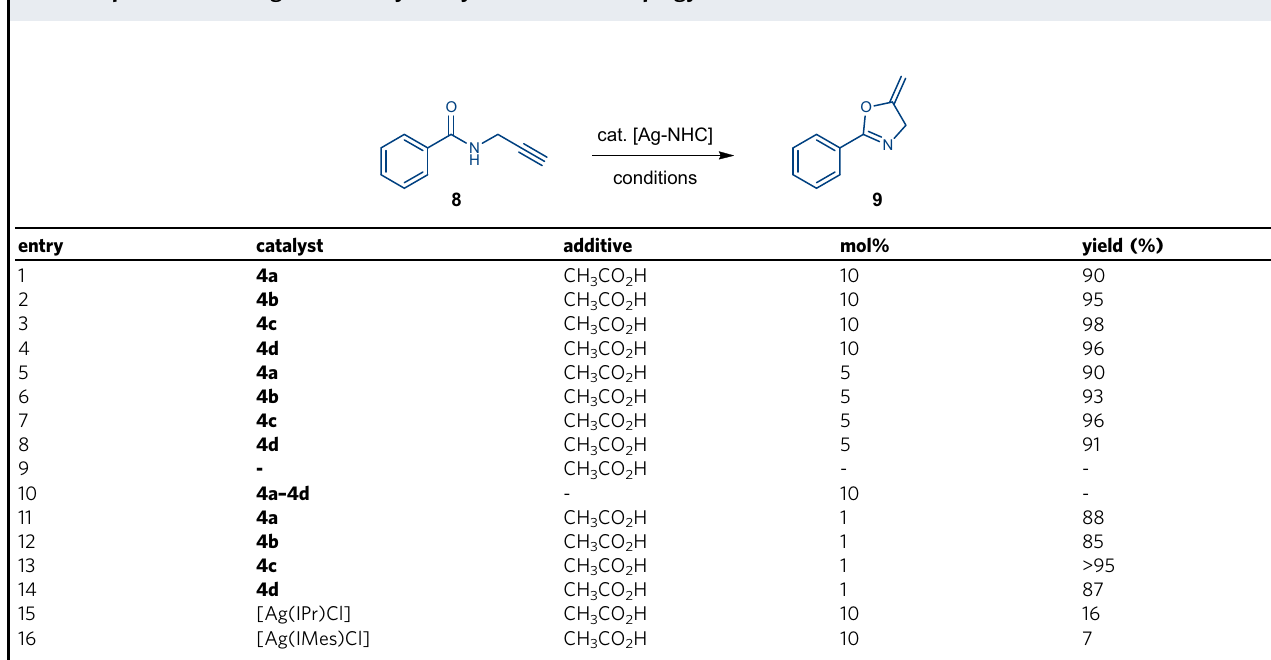
Table 1 Optimization of Ag – NHC-Catalyzed Cyclization of N-Propargylic Amides a